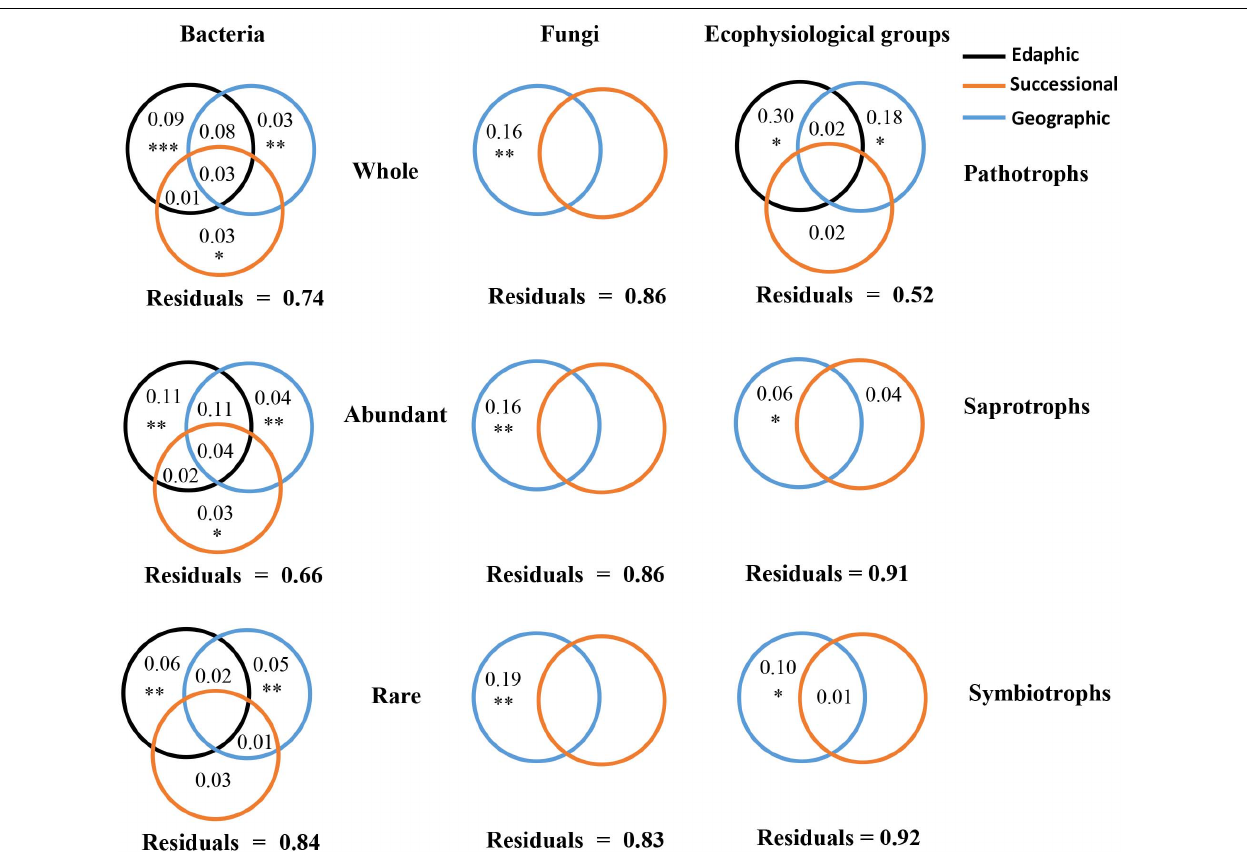
FIGURE 4 | Variation partitioning analysis for the relative contributions of edaphic, geographic, and successional variables to microbial subcommunities and ecophysiological groups. The significance of individual variables was evaluated by ANOVA permutation tests; ∗ and ∗∗ indicated p < 0.05 and < 0.01, respectively. Values < 0 were not